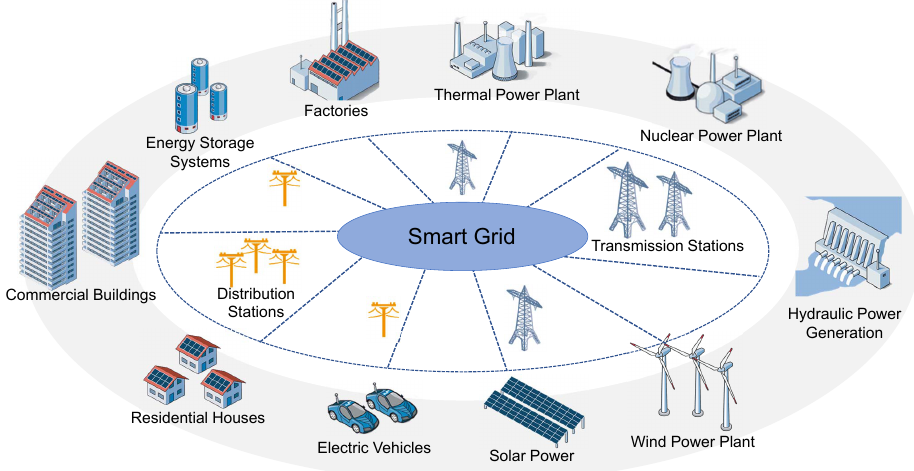
Figure 2. The smart grid framework